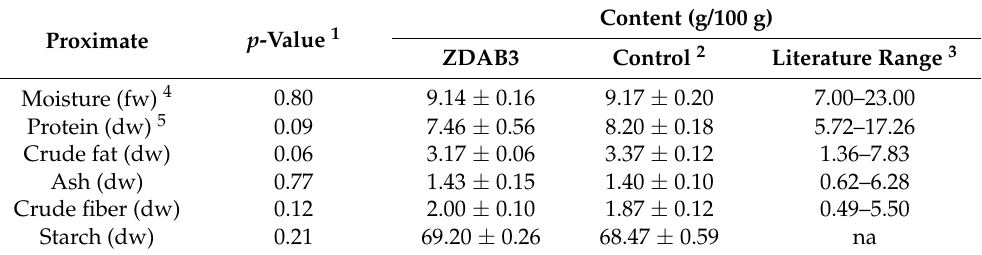
Table 3. Proximate values in maize samples.